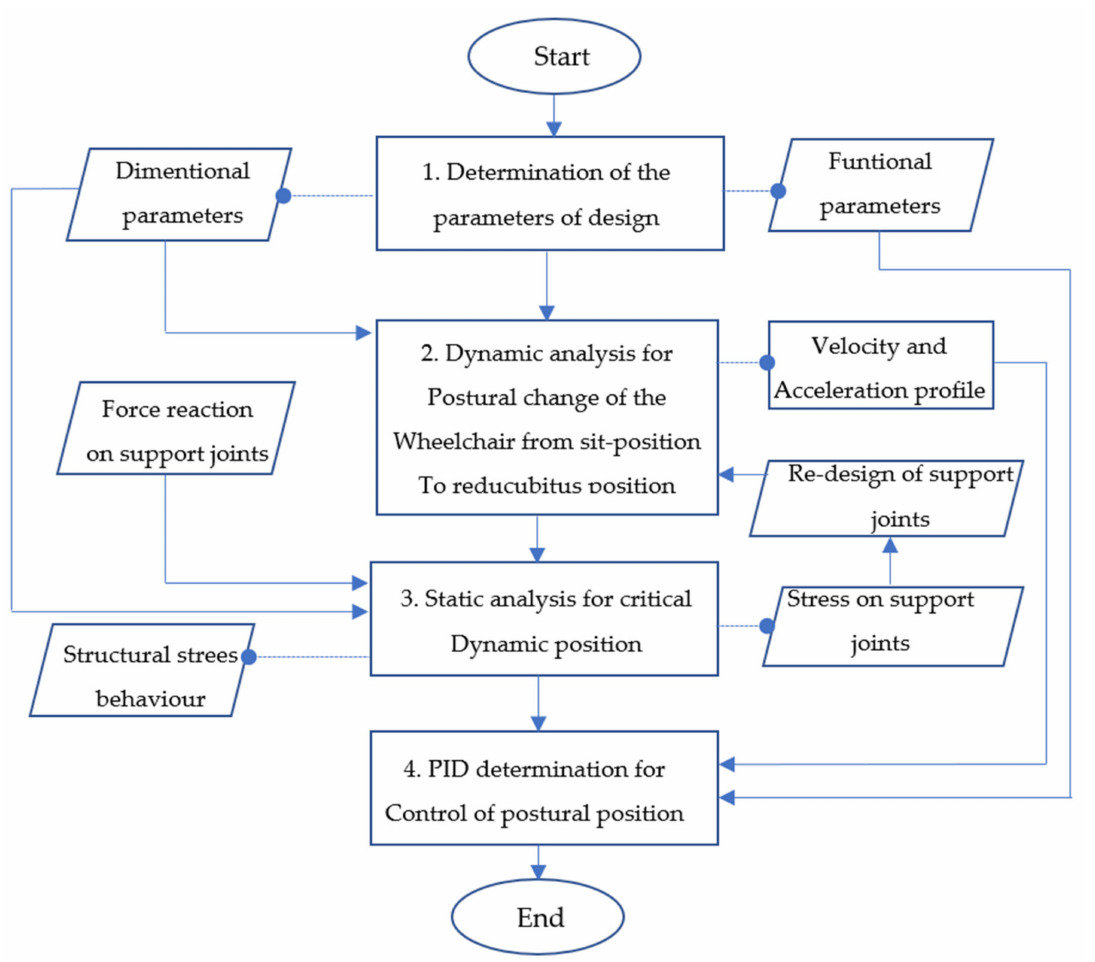
Figure 2. Wheelchair mechanism